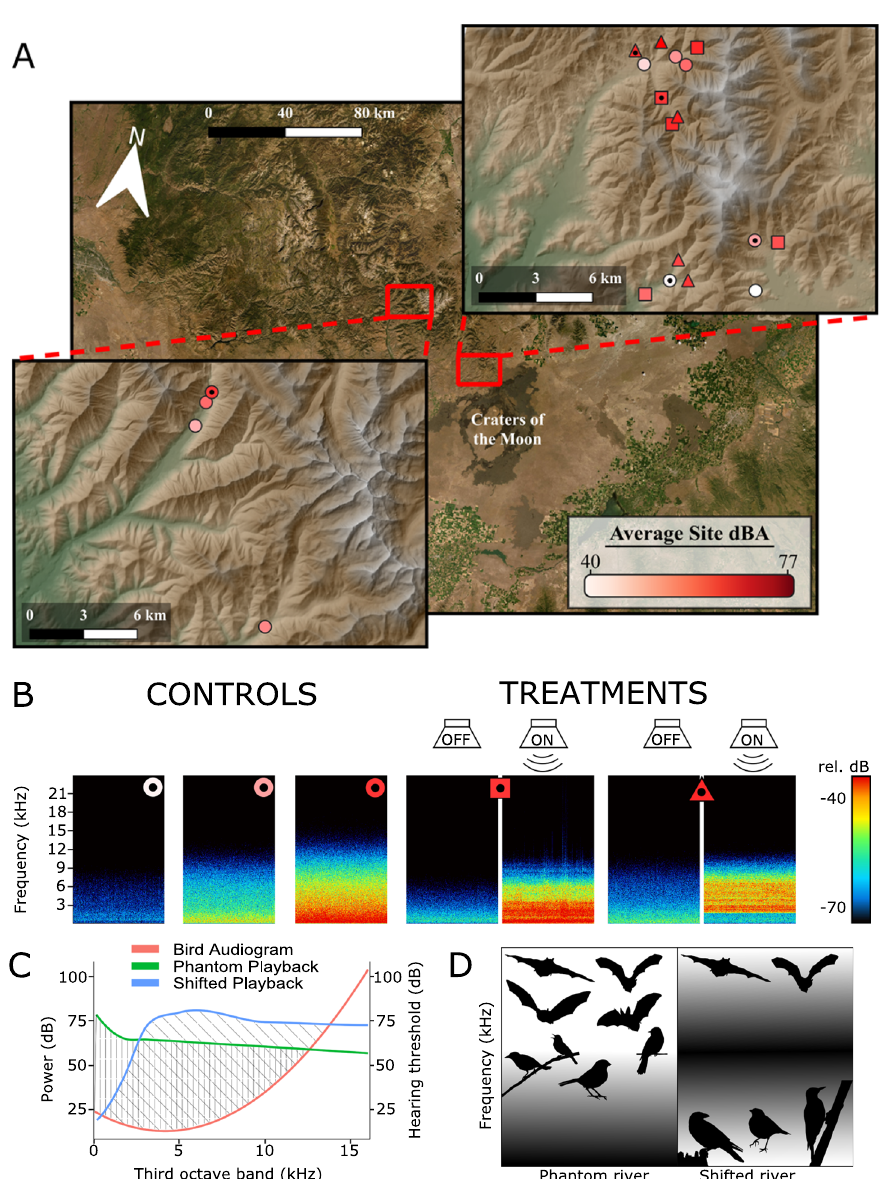
Fig. 1 Design and predictions for phantom rivers playback experiment. A Twenty sites were monitored across the Pioneer Mountains of Idaho, comprising a gradient of sound levels (indicated by color scale). Control sites are indicated by circles, phantom river playback sites by squares, and shifted- river playback sites by triangles. B These symbols are matched with their geographically referenced representative spectrograms (linked between A , B via black dots in center of symbols) to show the gradient of noise exposure at control sites and playback sites with speakers both on and off. C Both playback fi les were created so that the average broadcast energy, weighted by birds ’ hearing thresholds, was the same. D Predicted responses of birds and bats to the playback treatments. Silhouettes placed on frequency axis as a heuristic representation of vocalization frequency (not to